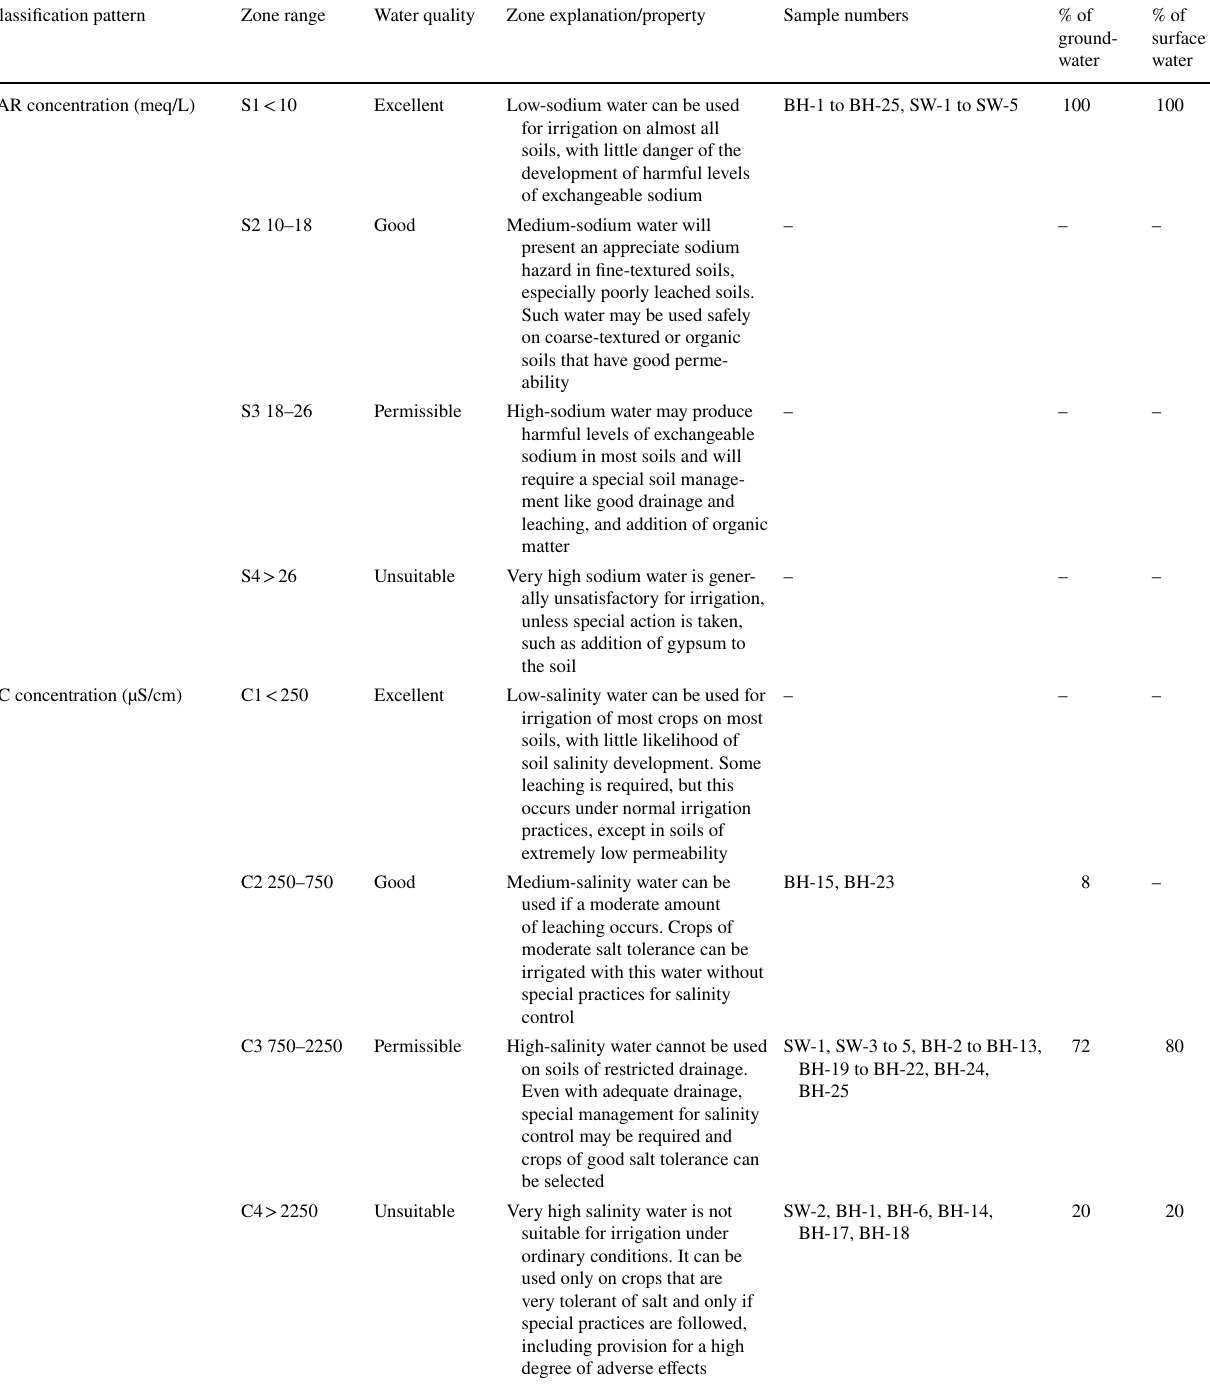
Table 9 Zone classification of water quality for irrigation on the basis of EC and